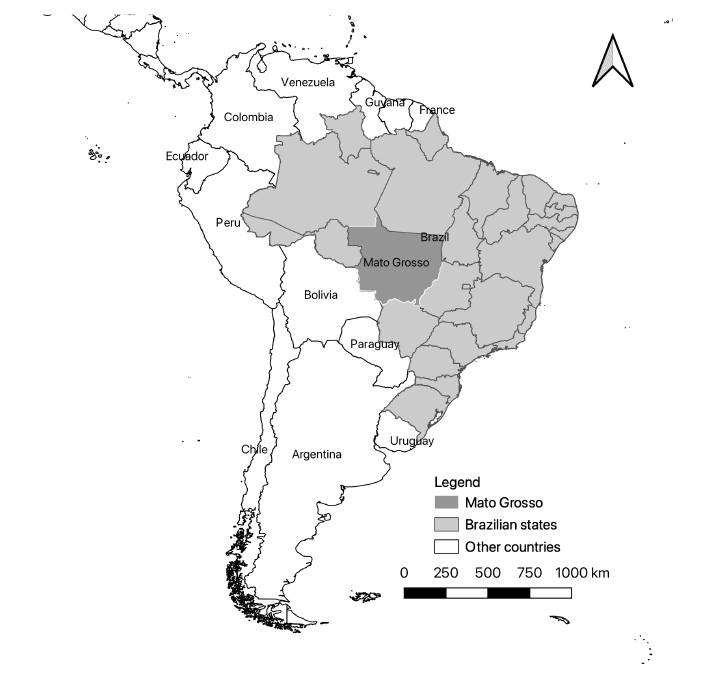
Figure 1. The location of Mato Grosso in